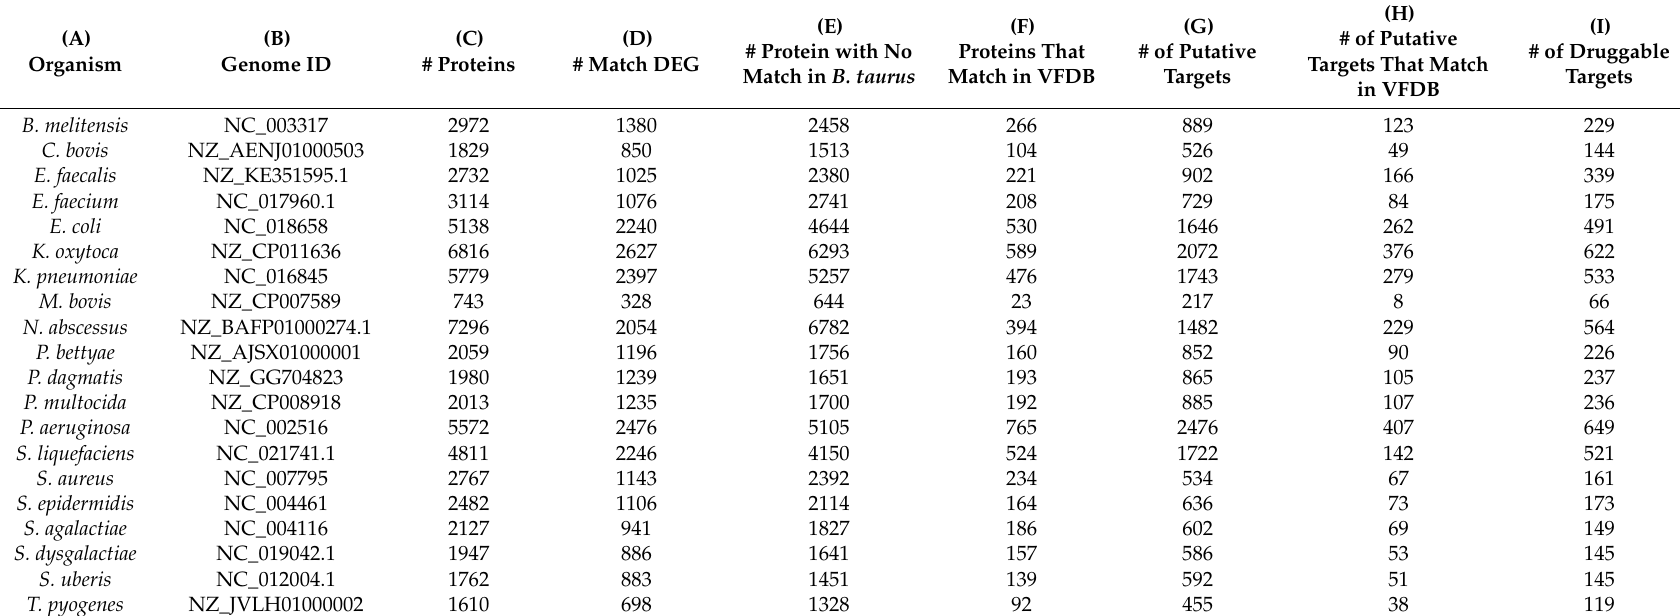
Table 1. Summary of genomic